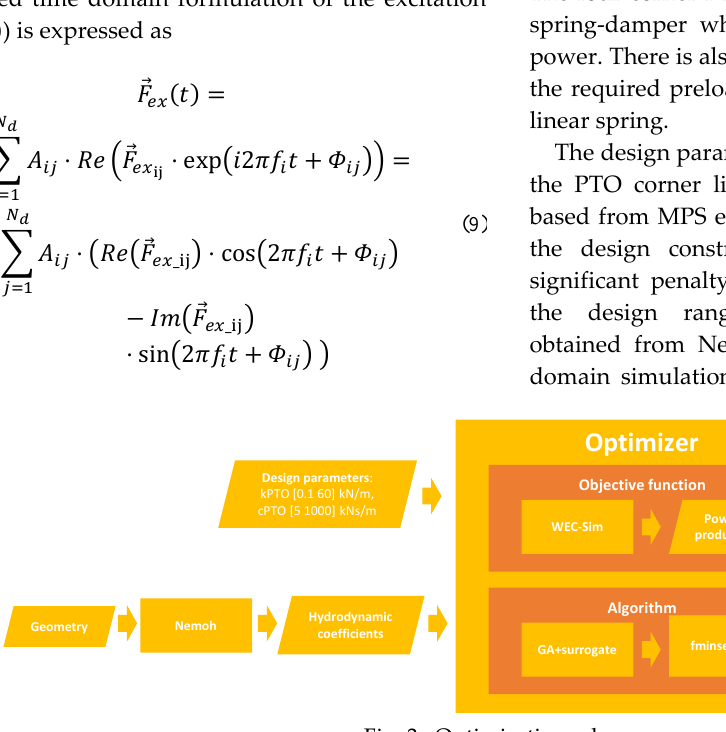
Fig. 3: Optimisation scheme.